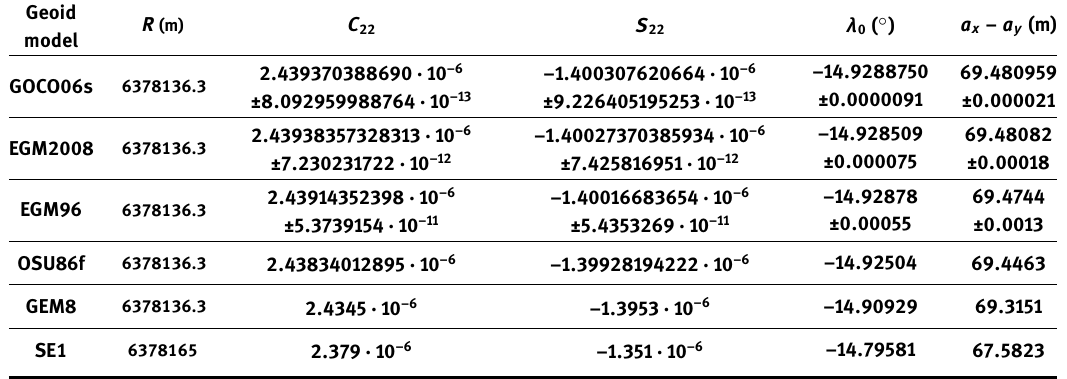
Table 9. Data and estimated values for the parameters for the geoid models Geoid